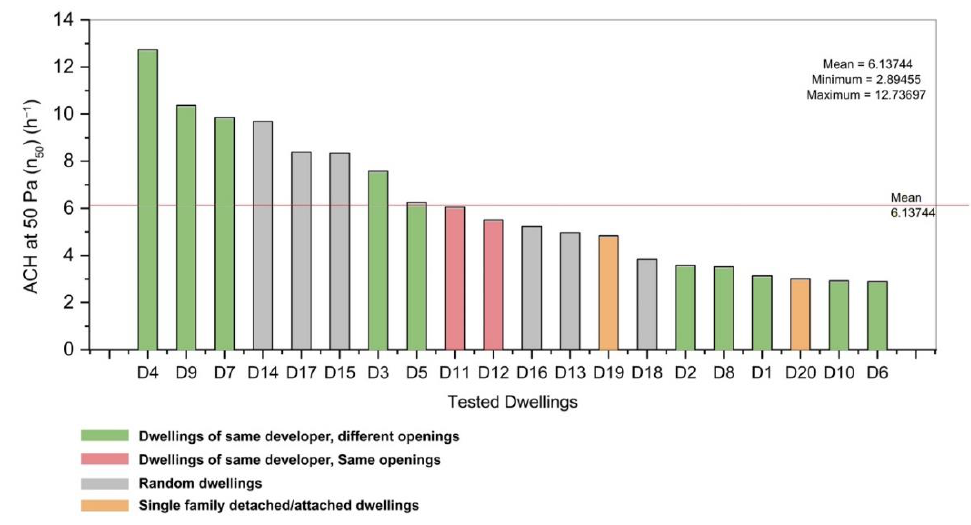
Figure 7. Air change rate at 50 Pa and n 50 for the tested dwellings (categorized as per Figure 1).